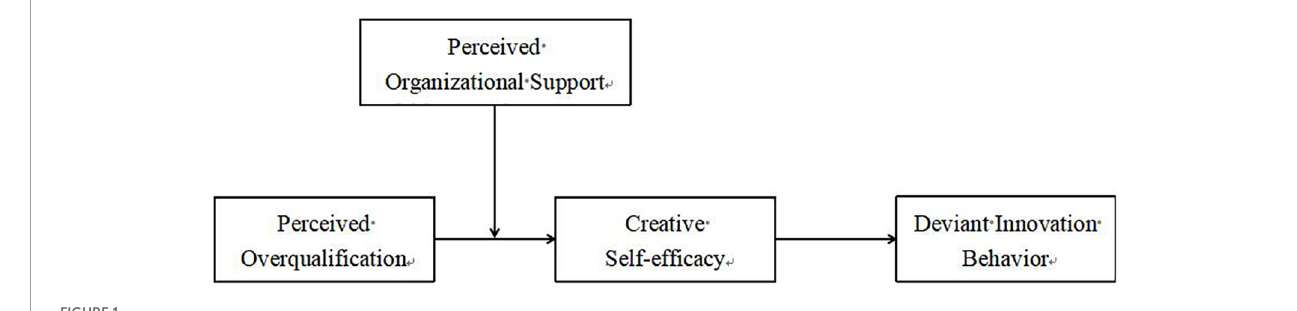
FIGURE1 Theoretical model.